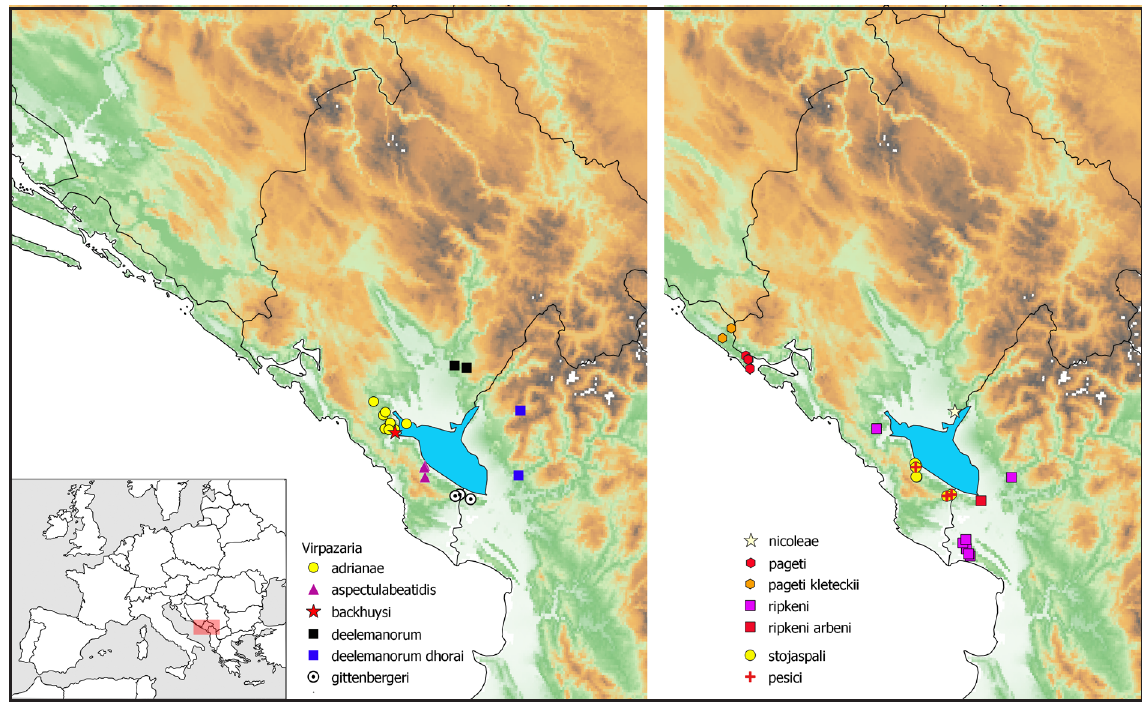
Fig. 2. Distribution of species of Virpazaria Gittenberger, 1969 in the western part of the Balkan